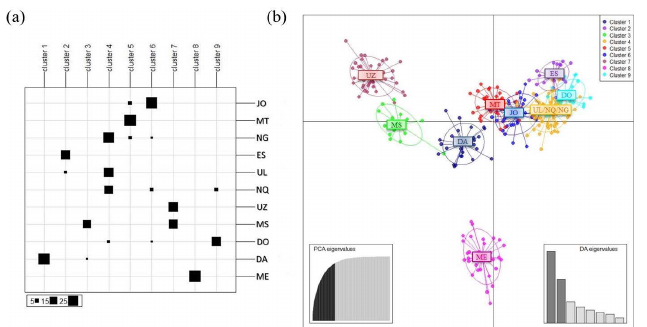
Fig 4. Assignment of individuals to 9 clusters based on DAPC analyses (a). Scatterplot of the first two principal components of DAPC using populations as a posteriori clusters (b). In Fig 4B, the individuals are assigned to populations a posteriori , that is, after determining the number of clusters by the programme, instead of forcing them into known populations. Populations are labeled inside their 95% inertia ellipses and dots represent individuals. The inset indicates the eigenvalues of the first four principal components and the variance explained by the PCA.